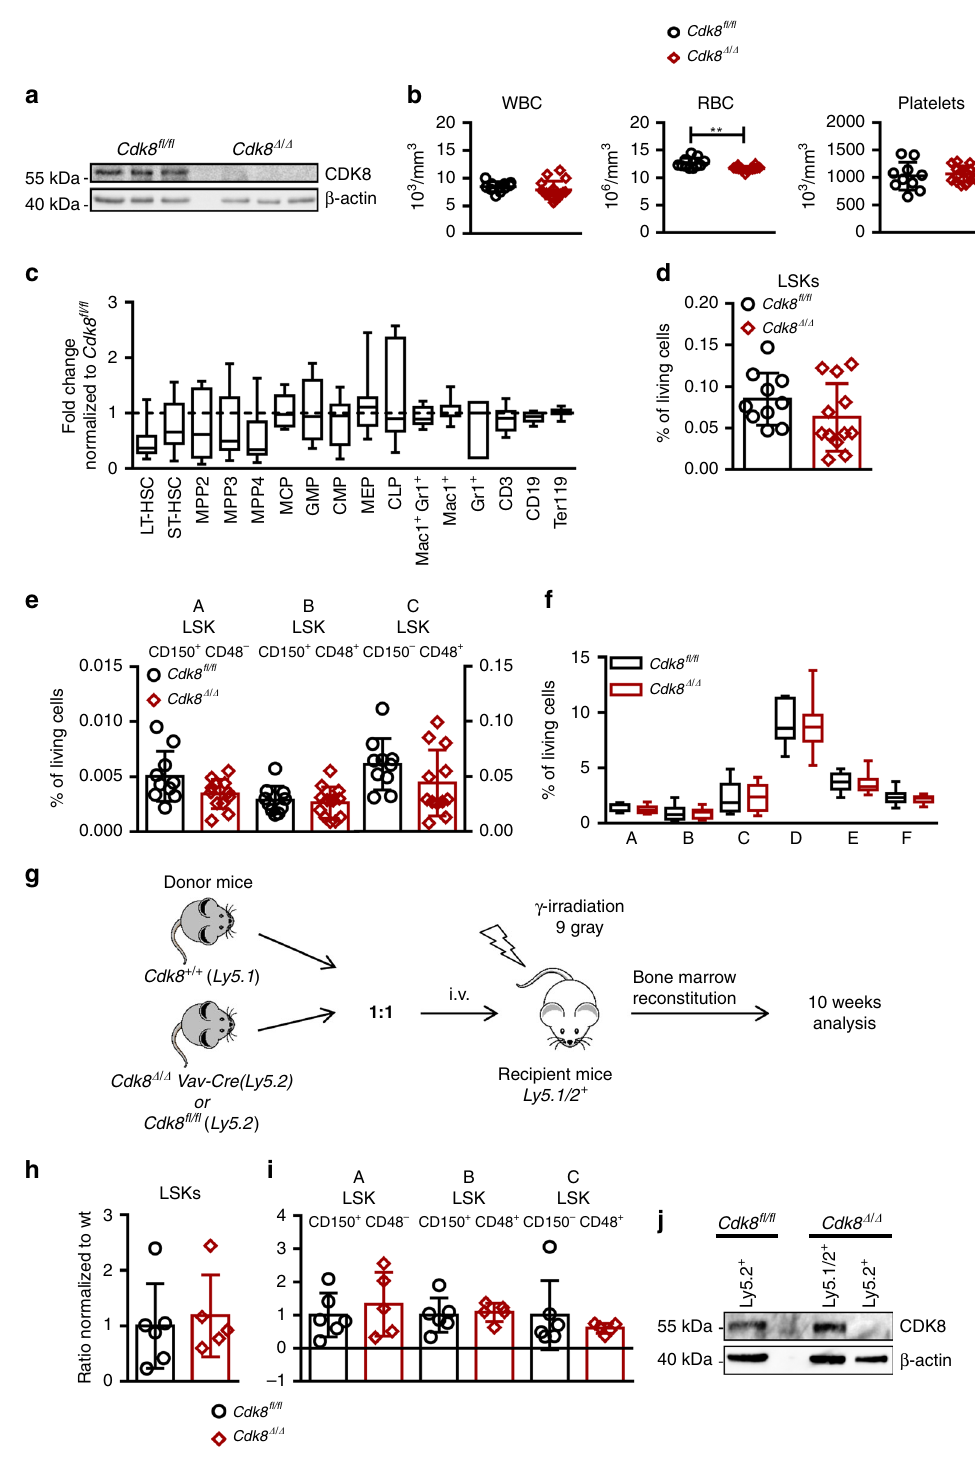
cells with a retrovirus encoding pMSCV- Bcr-Abl1p185 -IRES- eGFP or Ab-MuLV (encoding v-ABL p160 + ). Infected cells were subsequently plated in growth factor-free methylcellulose. Irrespective of the genotype, comparable numbers of B-lymphoid colonies grew out (Fig. 3a and Supplementary Fig. 3a). De fi ciency of CDK8 did not affect the levels of CDK19, MED12, MED13, or CNCC (Fig. 3b and Supplementary Fig. 3b). Transformation by BCR-ABL1 p185 + or v-ABL p160 + resulted in the outgrowth